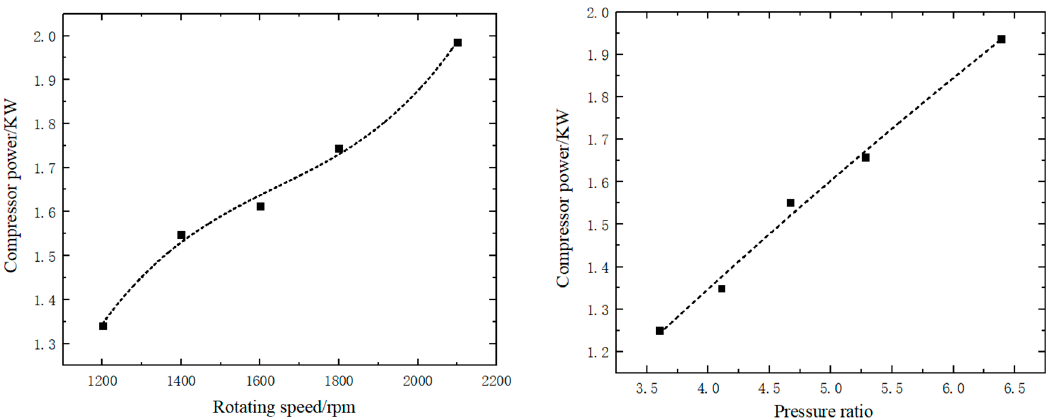
Figure 14. Volumetric efficiency of the scroll compressor coated with DLC film. Figure 15. Power consumption of the scroll compressor coated with DLC film. Figure 15. Power consumption of the scroll compressor coated with DLC film.